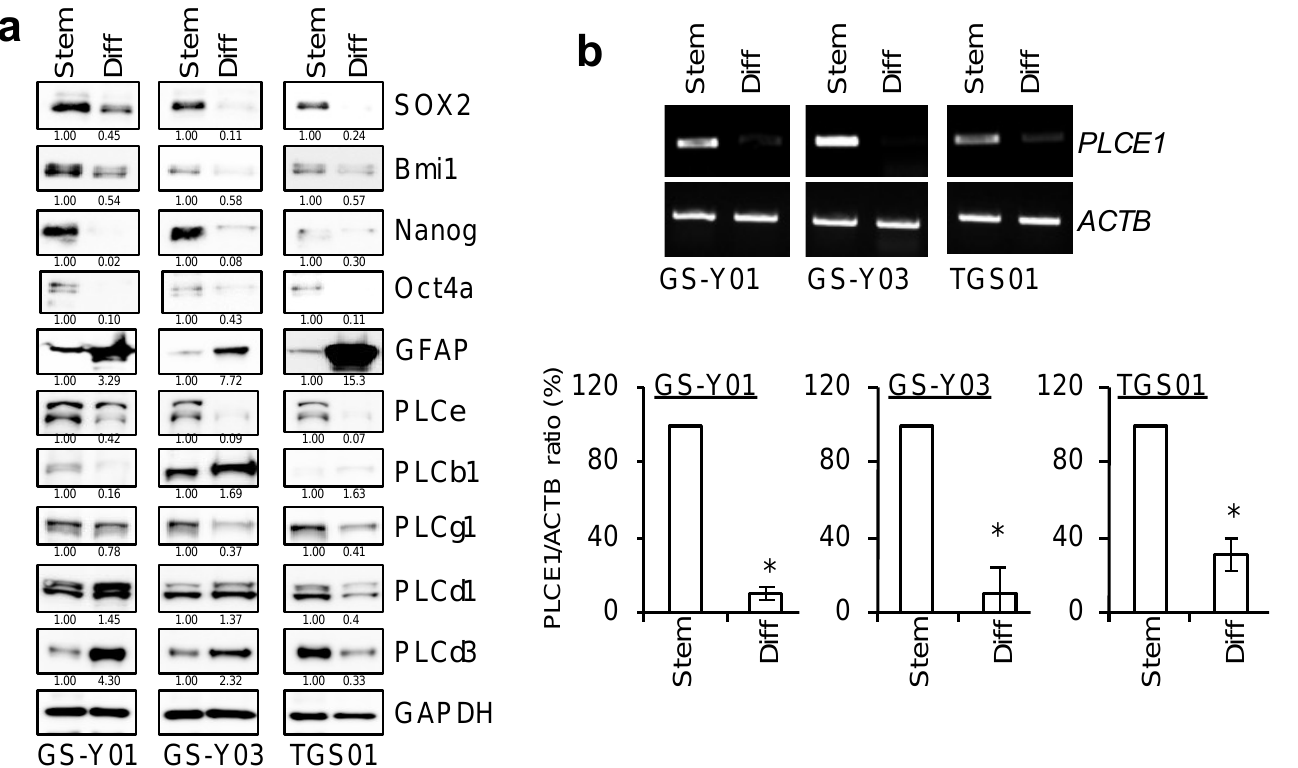
Figure 1. PLC ε is highly expressed in glioma stem cells (GSCs), but not in differentiated GSCs. GSCs (GS-Y01, GS-Y03, and TGS01; Stem) and isogenic differentiated GSCs (Diff) were evaluated by immunoblot analyses ( a ) or RT-PCR ( b ) for the indicated proteins and mRNAs. Representative images of two ( a ) or three ( b ) biological replicates are shown. The numbers below the Western blot images show the relative band intensities after each band was quantified by densitometry and normalized by the GAPDH value. Graphs indicate the quantification of PCR analyses by densitometry. The values are presented as the means ± SDs of the triplicate samples of an independent experiment. * p < 0.05 vs. Stem by the Student’s t